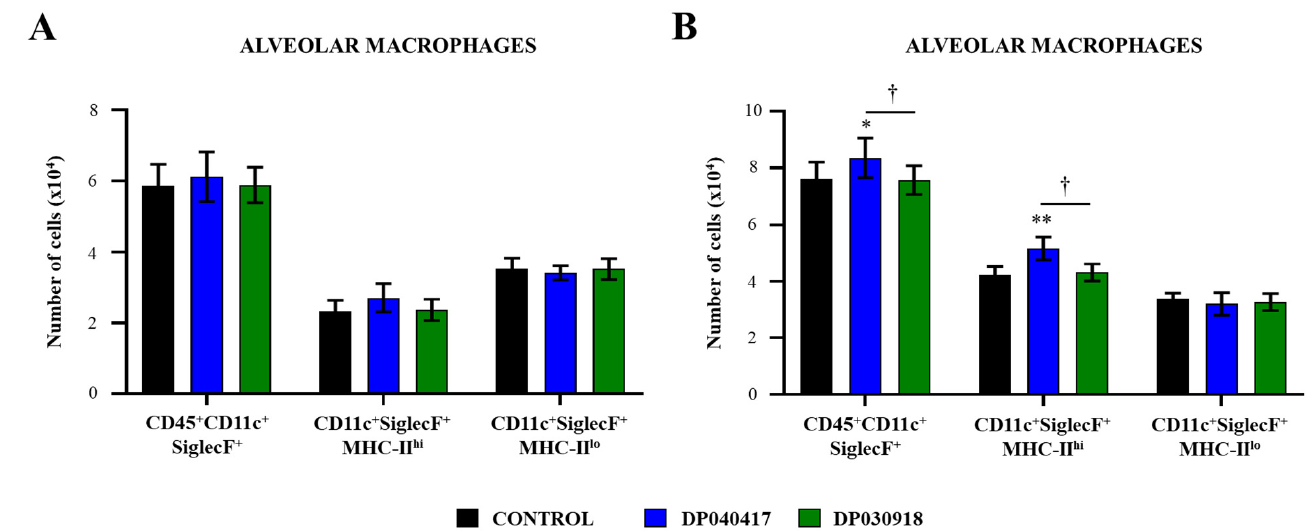
Figure 6. Effect of the respiratory commensal bacteria Dolosigranulum pigrum on resistance to Streptococcus pneumoniae infection. Infant mice were nasally primed with viable D. pigrum (DP) strain 040417 or 030918 during five consecutive days at a dose of 10 8 bacterial cells/mouse/day. One day after the last administration of DP strains, mice were challenged with S. pneumoniae serotype 3. Non-treated infant mice challenged with S. pneumoniae were used as controls. Total resident alveolar macrophages populations in broncho-alveolar lavages (BAL) (CD45 + CD11c + SiglecF + cells) as well as their expression of MHC-II were evaluated by flow cytometry before ( A ) and 2 days after ( B ) the bacterial infection. The results represent data from three independent experiments ( n = 6 per each group at each time point). Significantly different when compared with control at the same time point, * p < 0.05 or ** p < 0.01. Significantly differences between the indicated groups, † p < 0.05.